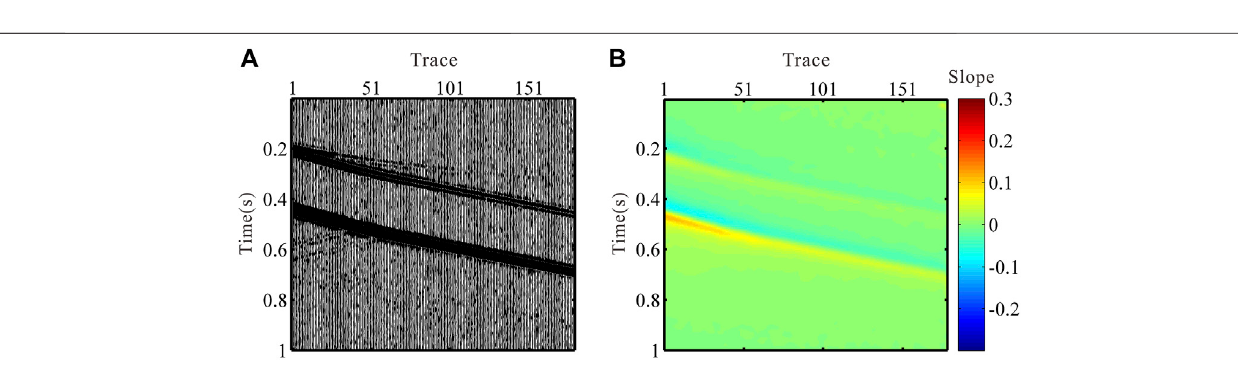
Frontiers in Earth Science |